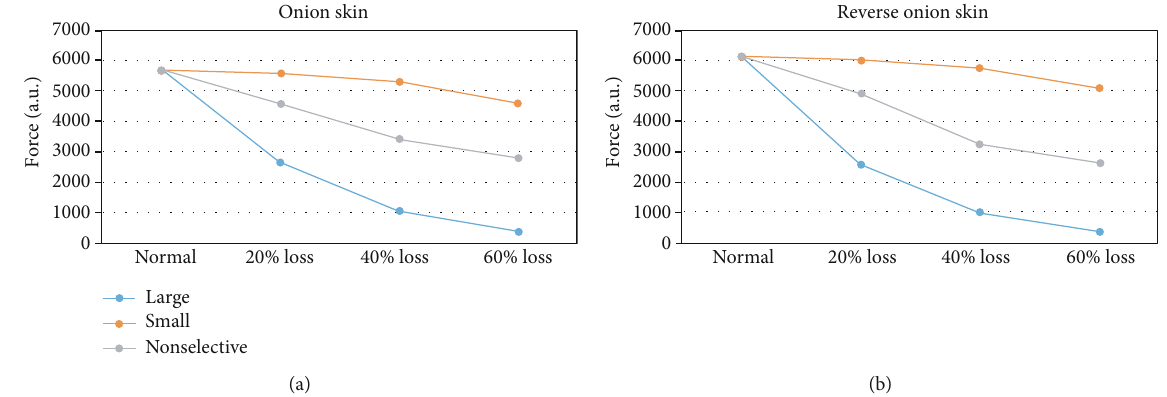
Figure 4: The simulated muscle force generation capacity (i.e., at 100% excitation) for di ff erent patterns and levels of motor unit loss in (a) the “ onion skin ” and (b) reverse “ onion skin ” motor unit fi ring strategies.